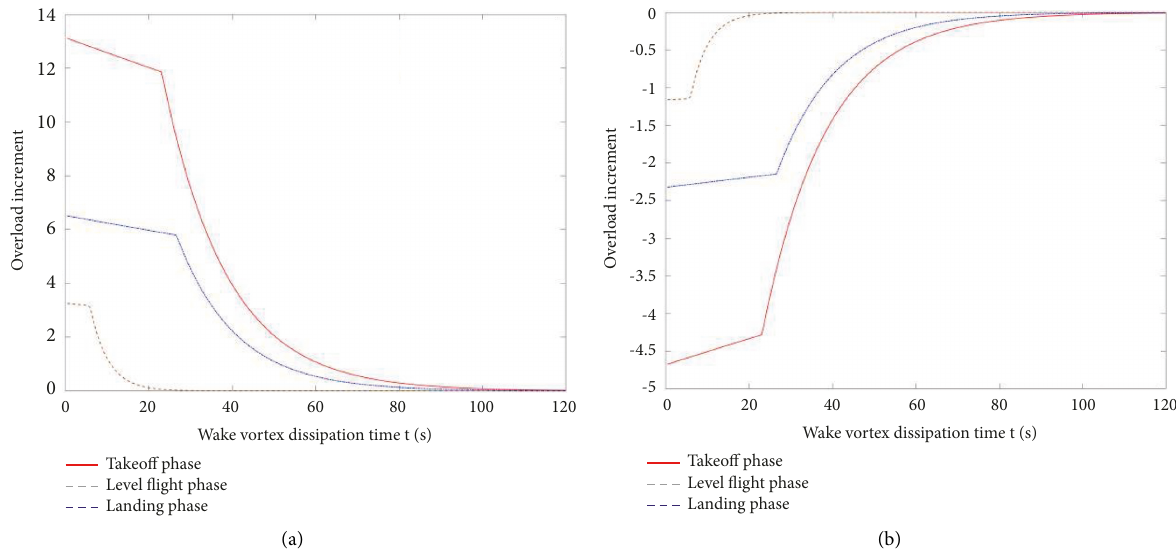
Figure 15: Schematic diagram of variation of wake vortex overload increment with wake vortex dissipation time before CRJ900 crossing. (a) Maximum up wash overload increment. (b) Maximum down wash overload Table 12: Fuel consumption and pollutant emission reduction under different RMC values.